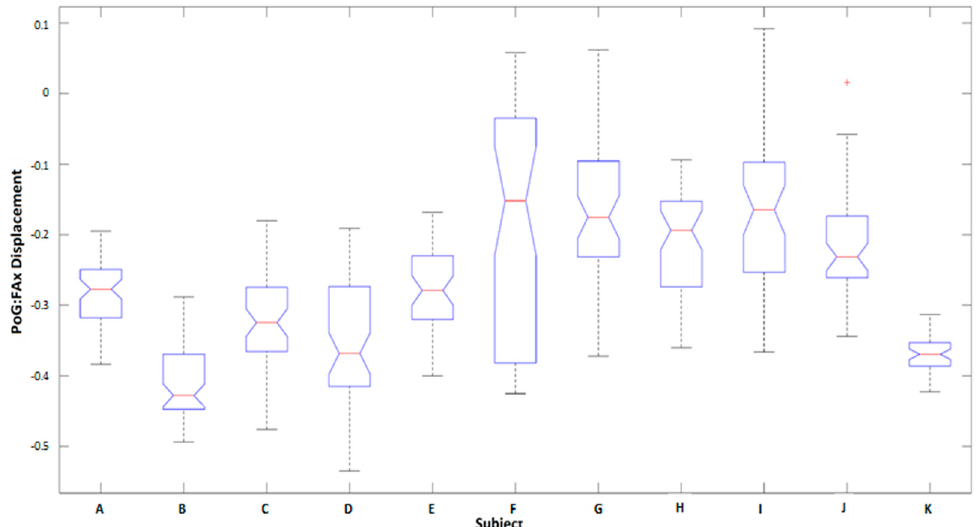
Figure 7. Comparison of individual subject PoG:Disp-FAx distributions for lateral grasps made on the bottle at table height and ascending positions. The median and variance of the feature are considerably varied between subjects. Participant K is the amputee.